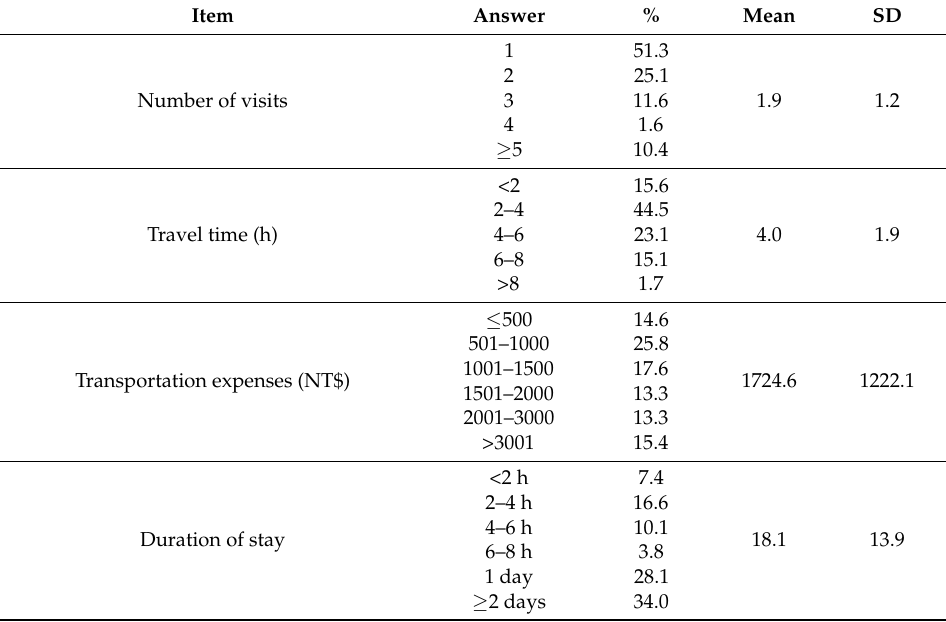
Table 2. Tourist’s recreational behaviors and travel